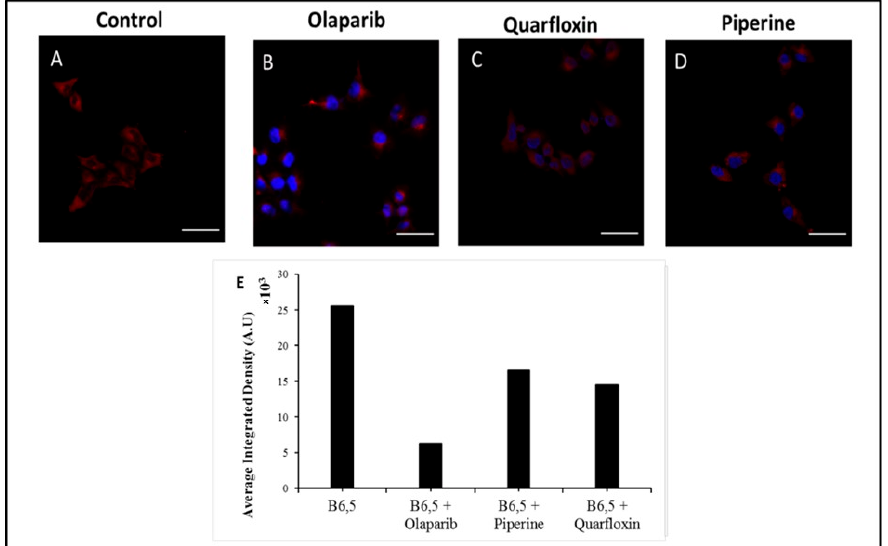
Figure 9. CLSM images of B6,5 stained fixed HeLa cells ( A ) control; without ligand treatment, ( B ) Olaprib treated, ( C ) Quarfloxin treated, and ( D ) Piperine treated cells, which shows fluorescence quenching of B6,5. For clarity, images are presented in pseudo colors of red for B6,5 and blue for DAPI. The relative fluorescence quantification of B6,5 and ligand treated cells is graphically represented in ( E ).